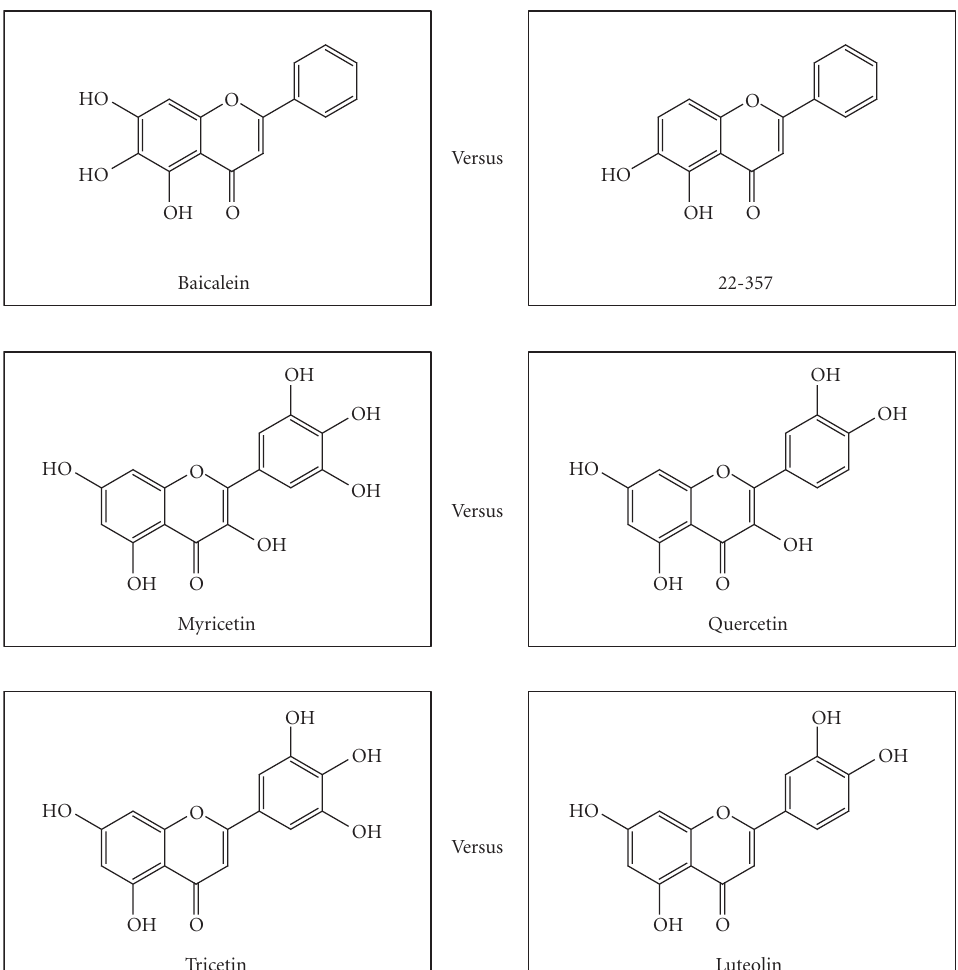
Figure 12: Flavonoids with three vicinal hydroxyl groups exhibit enhanced inhibitory e ff ects on α -synuclein fibrillation. Comparisons are made between the three pairs of